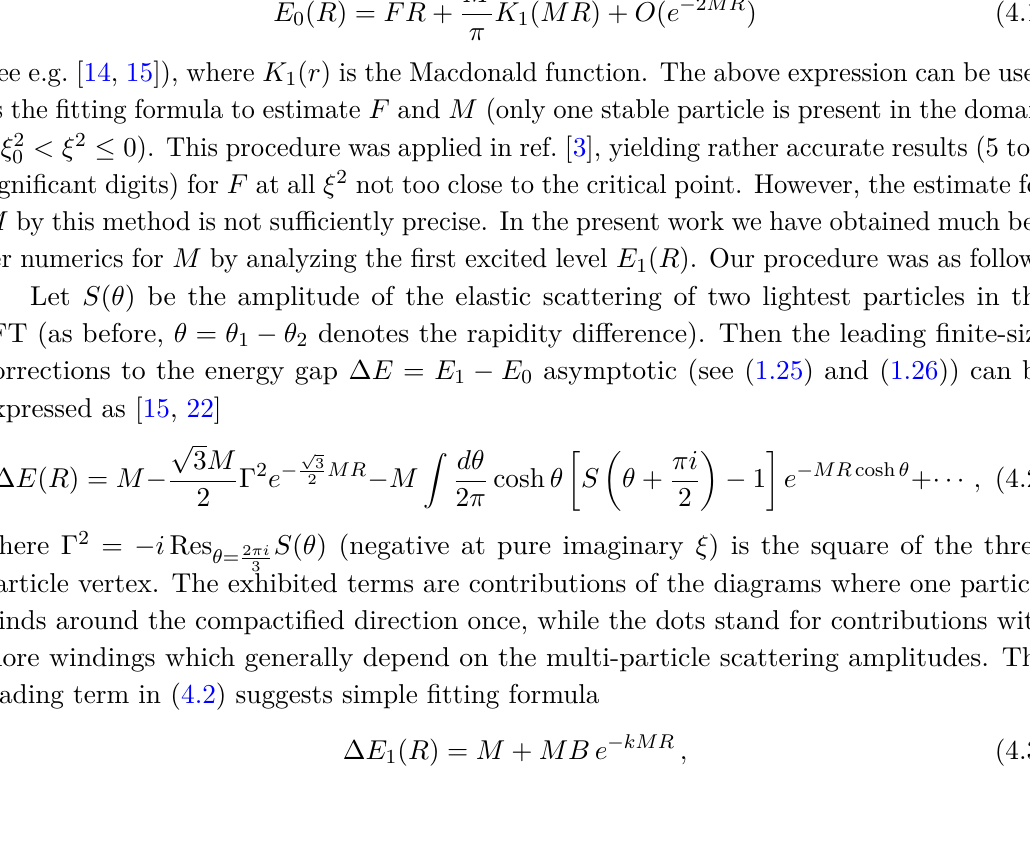
Figure 13 . Off critical spectrum, an example at ξ 2 = − 0 . 0169 > − ξ 2 gap between E 0 ( R ) and E 1 ( R ) . Note that for states above E 2 ( R ) different energy eigenvalues exhibit level crossing, forming complex conjugate pairs at intermediate values of R (only real parts are shown in this plot). All levels become real at sufficiently large R